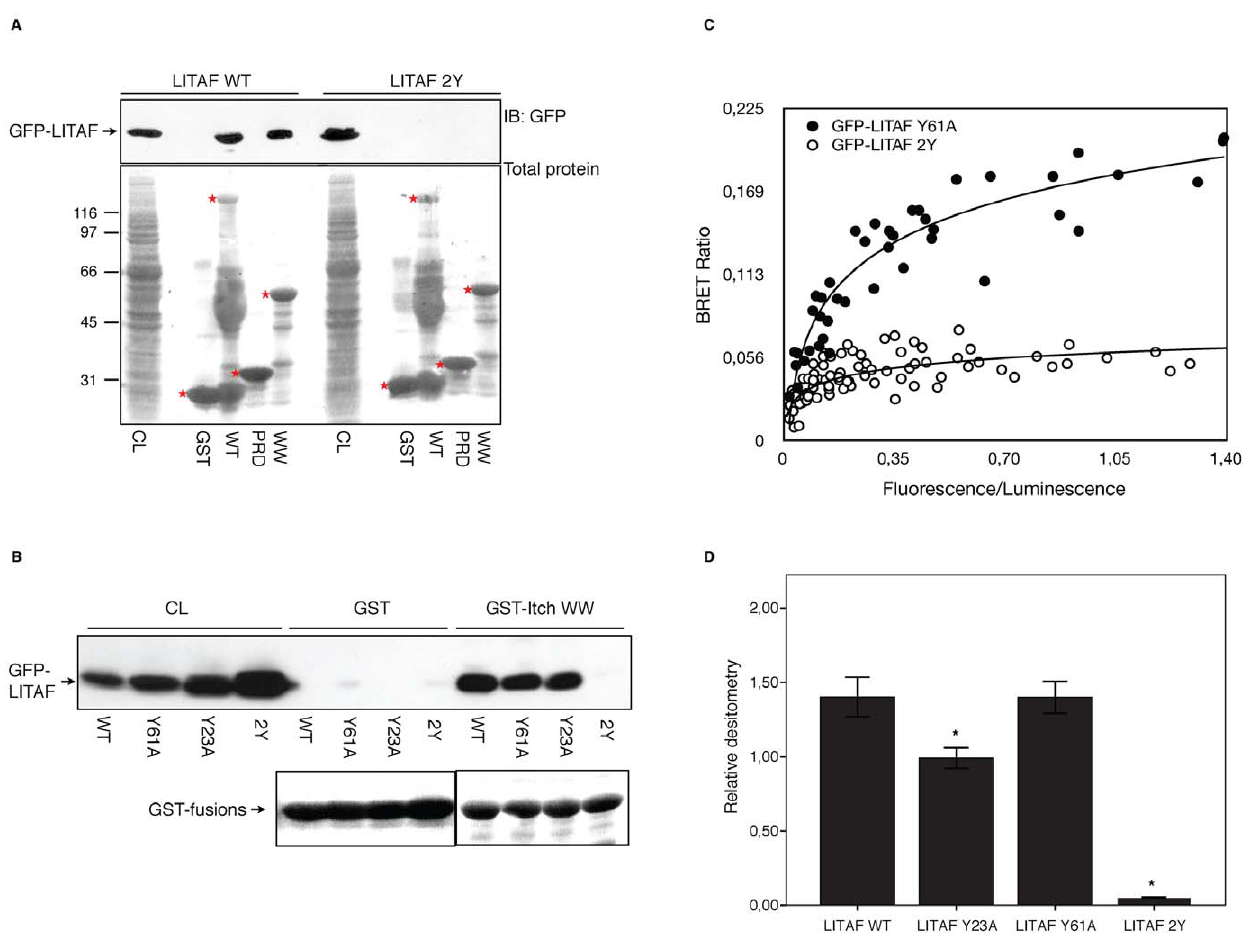
Figure 4. Mutation of both PPXY domains disrupts Itch and LITAF interaction. (A) Extracts from HEK-293T cells transfected with GFP-LITAF WT or GFP-LITAF Y23,61A were incubated with either GST alone, GST-Itch WT, GST-Itch PRD or GST-Itch WW pre-coupled to glutathione-Sepharose. Aliquot from total cell lysate (CL) and proteins specifically bound to the beads were processed by immunoblot with a polyclonal antibody against GFP. (B) HEK-293T cells were transiently transfected with either GFP-LITAF WT, GFP-LITAF Y61A, GFP-LITAF Y23A or GFP-LITAF Y23,61A. Aliquots of CL were processed by immunoblot with GFP antibody to show protein expression. The rest of the extracts were incubated with either GST or GST-Itch WW fusion proteins pre-coupled to gluthatione-Sepharose. Proteins specifically bound to the beads were immunoblotted with GFP antibody to reveal protein interactions. The bands representing the GST-fusions in the Ponceau staining are marked by a red asterisk. Additional staining in the GST-Itch-WT lane likely represents degradation products of the fusion protein. (C) 293T cells were co-transfected with constant amount of rLuc-Itch and various amounts of either GFP-LITAF Y61A or GFP-LITAF Y23,61A. The graph is a representative example of the saturation studies performed to provide evidence for a specific interaction between the proteins. BRET ratios were plotted as a function of the excited GFP activity to total rLuc activity ratio, allowing comparison of BRET ratios between GFP-LITAF Y61A and GFP-LITAF Y23,61A when expressed at the same level. (D) Quantification of the interaction between Itch WW domains and the different LITAF constructs. The densitometry of GFP signal in the fraction bound to GST-Itch-WW beads relative to the densitometry of the GFP signal in 1/10 volume of protein extract is represented as described in materials and methods. Data are mean 6 s.e.m. from n=4 experiments. * p , 0.05 compared to binding of GFP-LITAF WT (ANOVA post-hoc